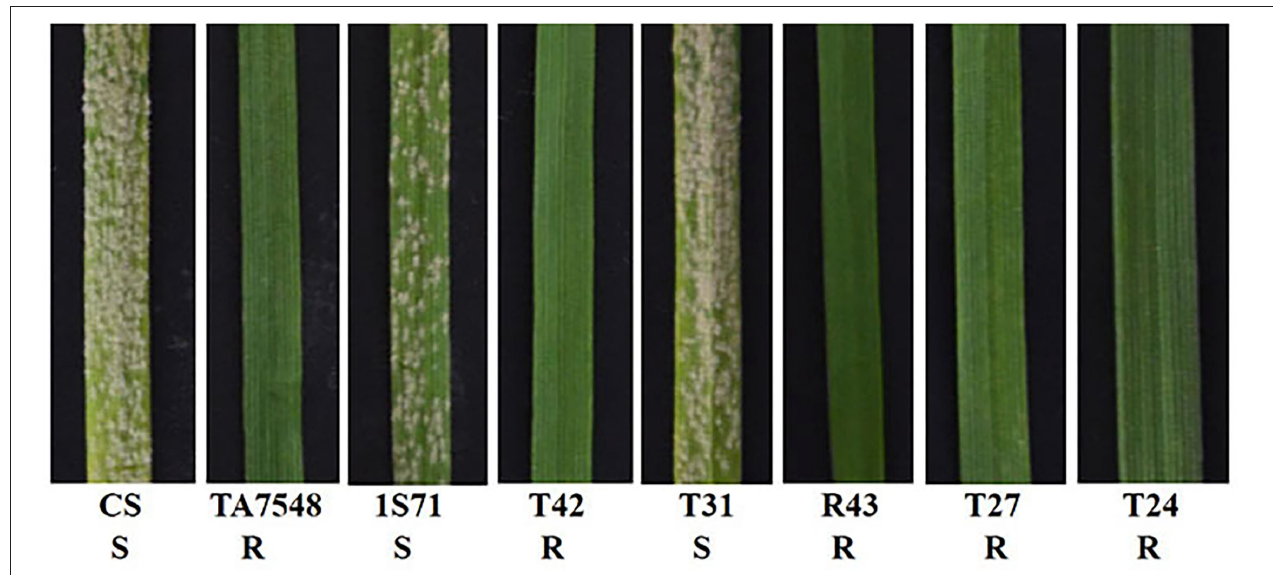
FIGURE 3 | Powdery mildew resistance evaluation of 6S l #3 recombinants. 1S71: CS- Ae. longissima RobT T6S l #3S.6AL; T42: 6S l #3L telosome line; T31: CS- Ae. longissima T6S l #3S.6S l #3L-6AL recombinant; R43: CS- Ae. longissima T6BS.6BL-6S l #3L recombinant; T27: CS- Ae. longissima Ti6AS.6AL-6S l #3L-6AL recombinant; T24: CS- Ae. longissima T6S l #3S.6S l #3L-6AL recombinant. R: resistant to powdery mildew, S: susceptible to powdery mildew.